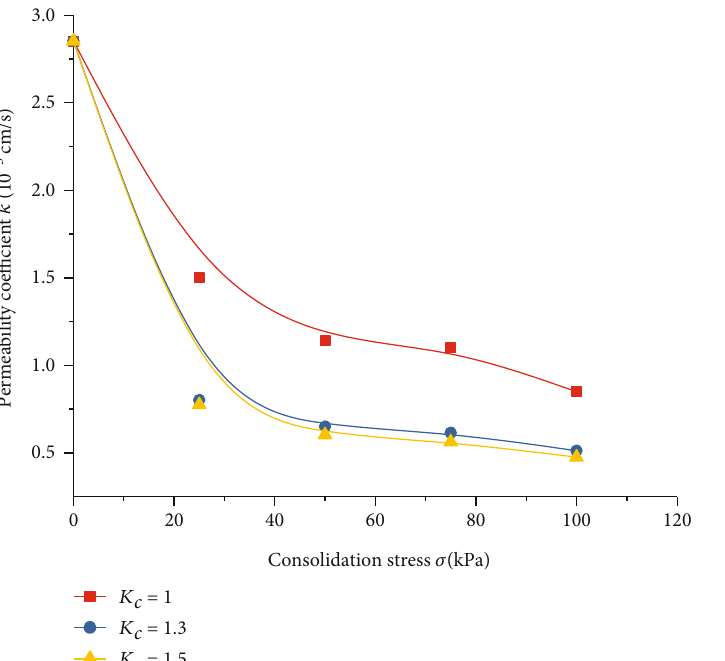
Figure 13: The curve of permeability coe ffi cient of overconsolidation clay with consolidation pressure at di ff erent consolidation stress ratios.